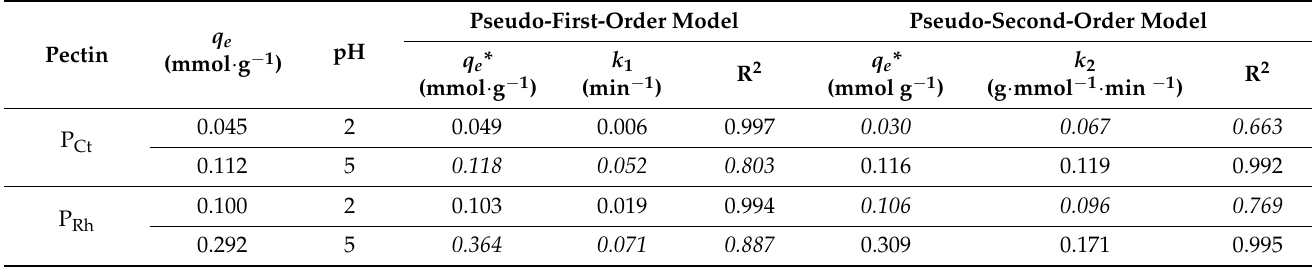
Table 6. Kinetic parameters of theophylline sorption by pectin preparations at 40 ◦ C.